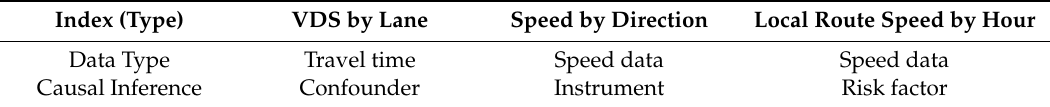
Table 5. Data type and causal inference in database of “Refreshing way to work”.